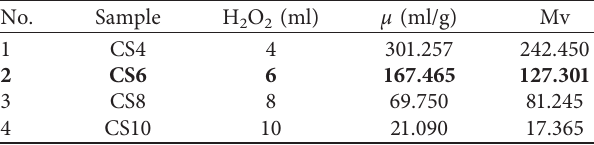
Bold signifies that sample CS6 gives results for viscosity and molecular weight which are more suitable than other samples